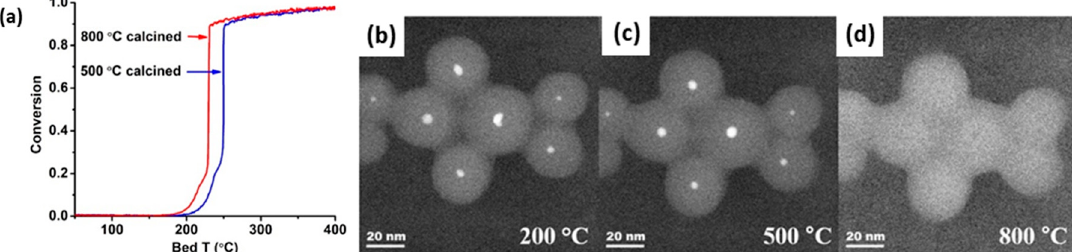
Figure 10. ( a ) CO oxidation light-off curves for Pd@SiO 2 after aging in air at 500 °C (blue) and at 800 °C (red). Reaction conditions: 2 °C/min, 1% ( V / V ) CO, 1.5% ( V / V ) O 2 , balance N 2 , total flow rate = 200 mL min − 1 , m cat = 60 mg. ( b )–( d ) In situ (S)TEM of Pd@SiO 2 after aging in 150 Torr O 2 at ( b ) 200 °C for 1h, ( c ) 500 °C for 30 min and ( d ) 800 °C for 30 min. Reprinted with permission from Ref. [169].